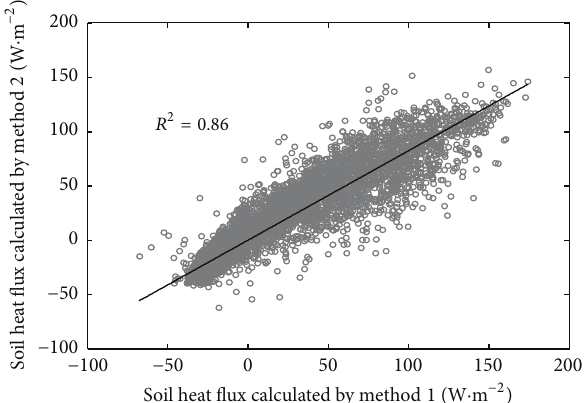
Figure 1: The relationship between calculated soil heat fluxes by two